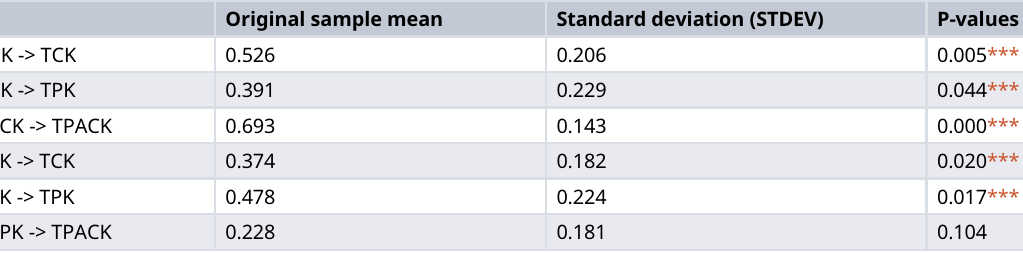
Table 4. Path coefficients.